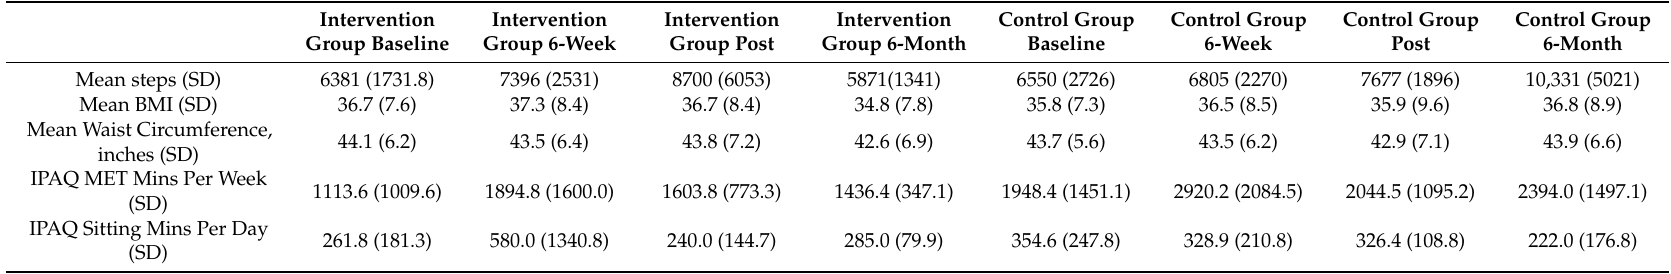
Table 4. Parental PA & Anthropometric Variables for Intervention and Control Groups, at Baseline, Mid-Intervention, Post-Intervention, and 6-Month Follow-Up. Intervention Group Baseline